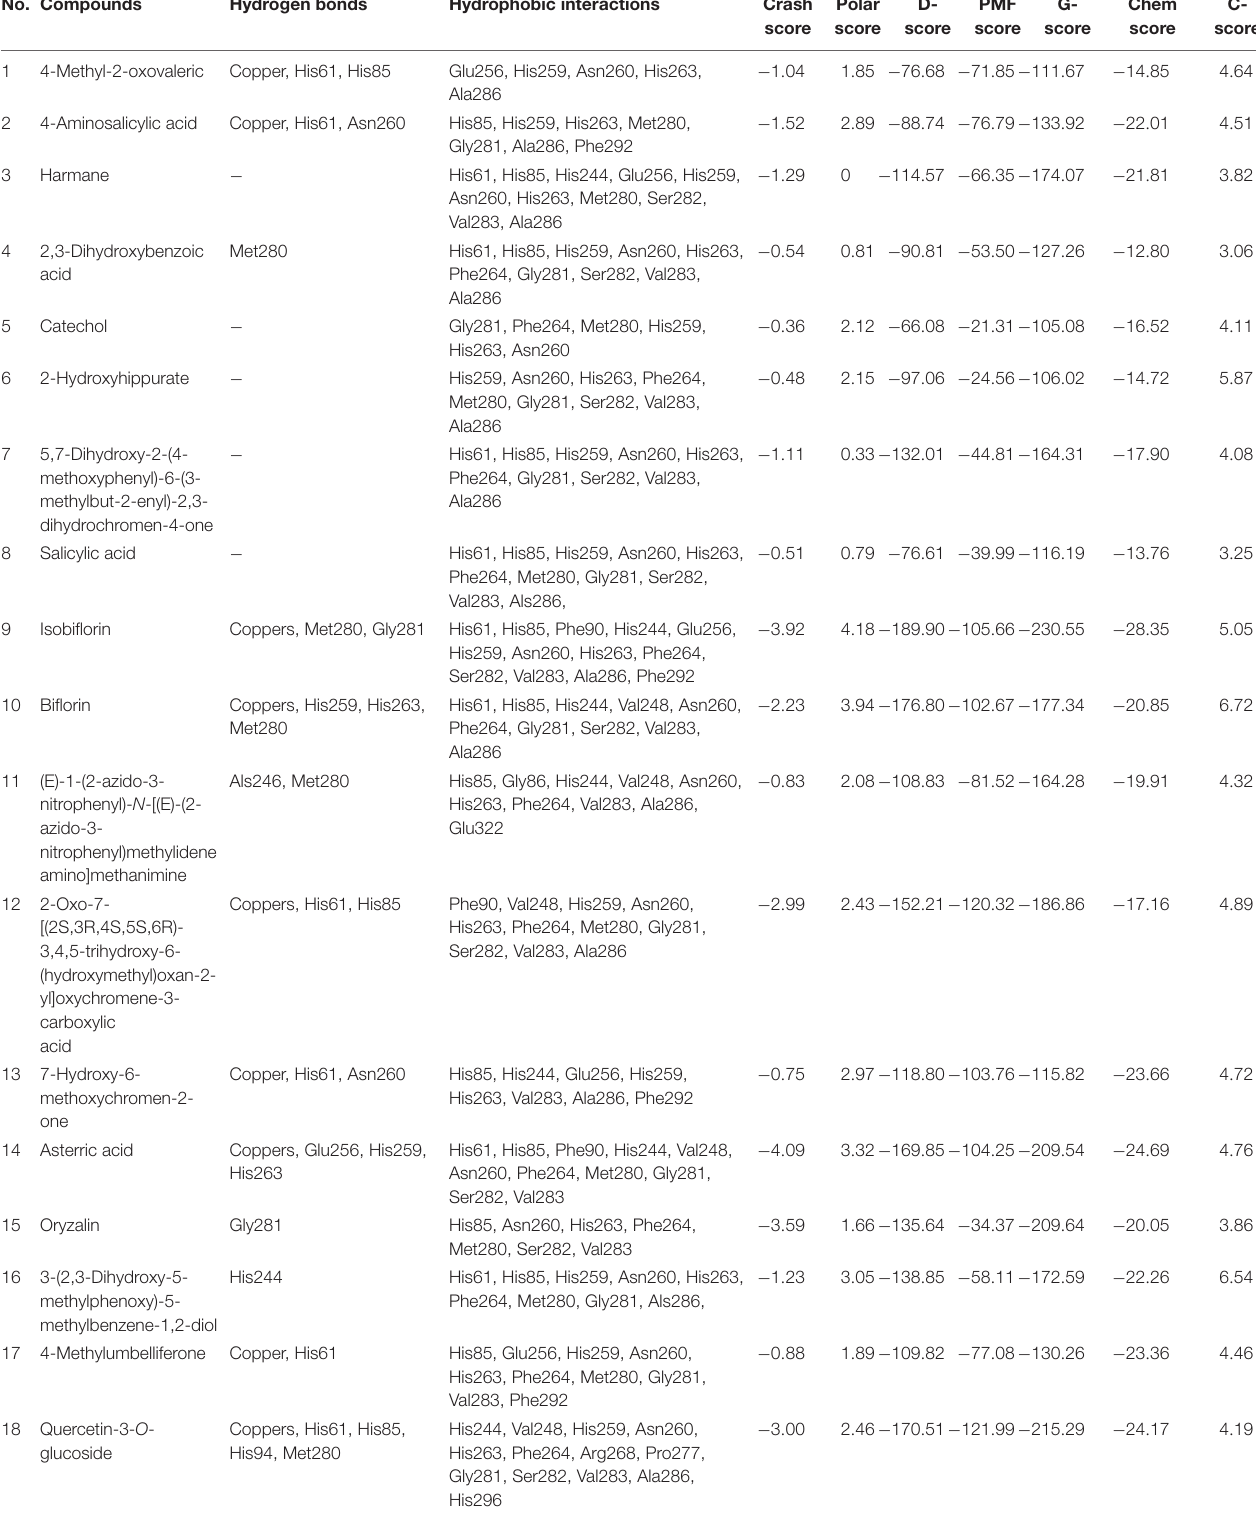
TABLE 2 | Docking scores and predicted interactions between the 22 Dryopteris crassirhizoma rhizome (DCR) compounds with tyrosinase inhibitory activity and tyrosinase. No.